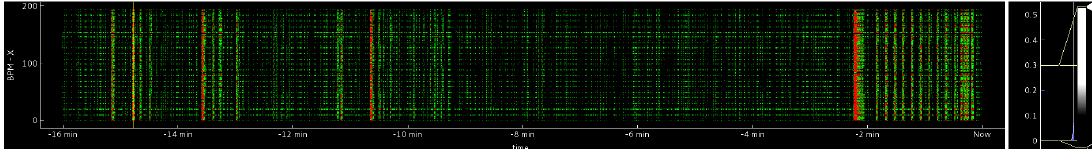
Figure 3. Beam position monitor (BPM) trends in the horizontal plane for the 3 GeV storage ring during stable-beam delivery. The vertical axis displays the BPM number, while the horizontal axis displays the time (in minutes). The green points indicate that fluctuations in the horizontal beam position remained within the set tolerance of ± 0.3 µ m. The vertical scale on the right (in µ m) controls whether there is any deviation within the lower and upper limits set by the scale.